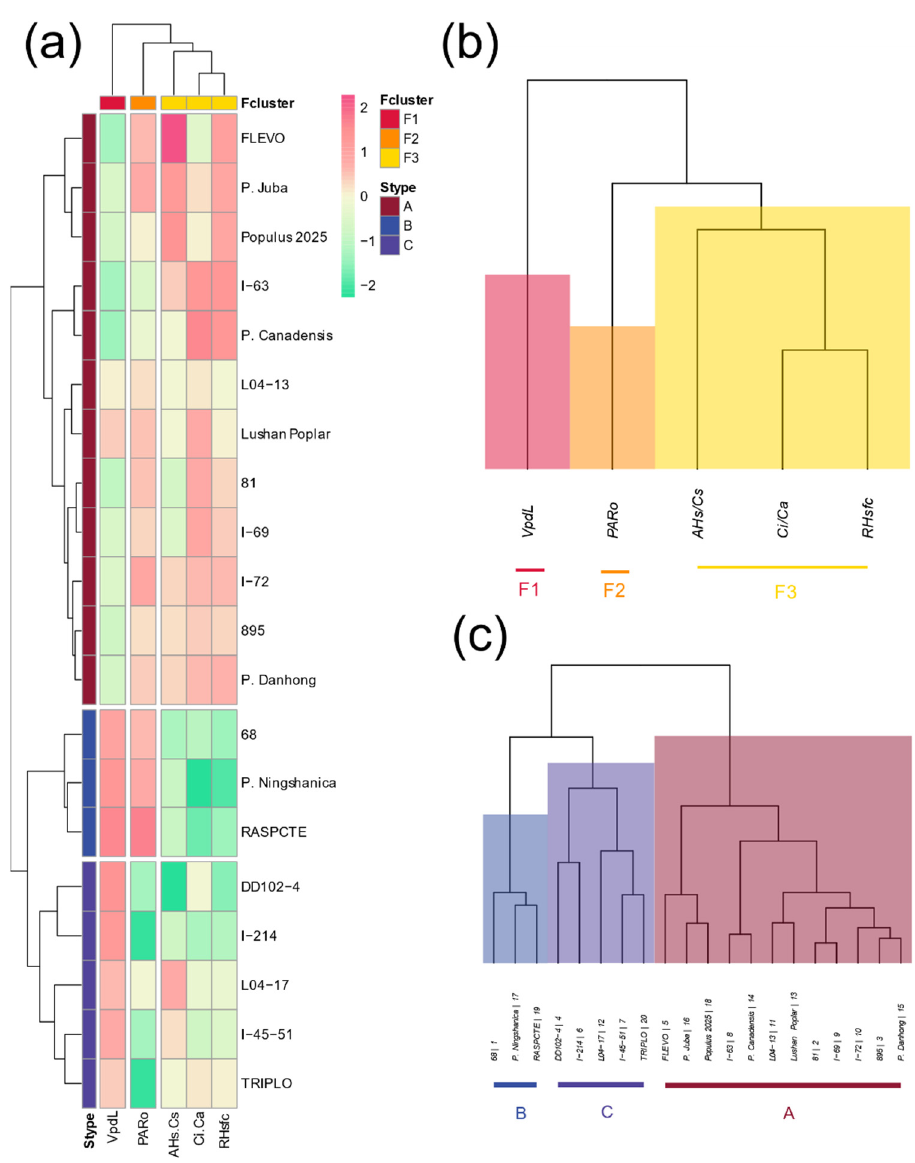
Figure 4. Results of features and samples clustering. ( a ) Total; ( b ) features; ( c ) varieties. Table 4. The result of features